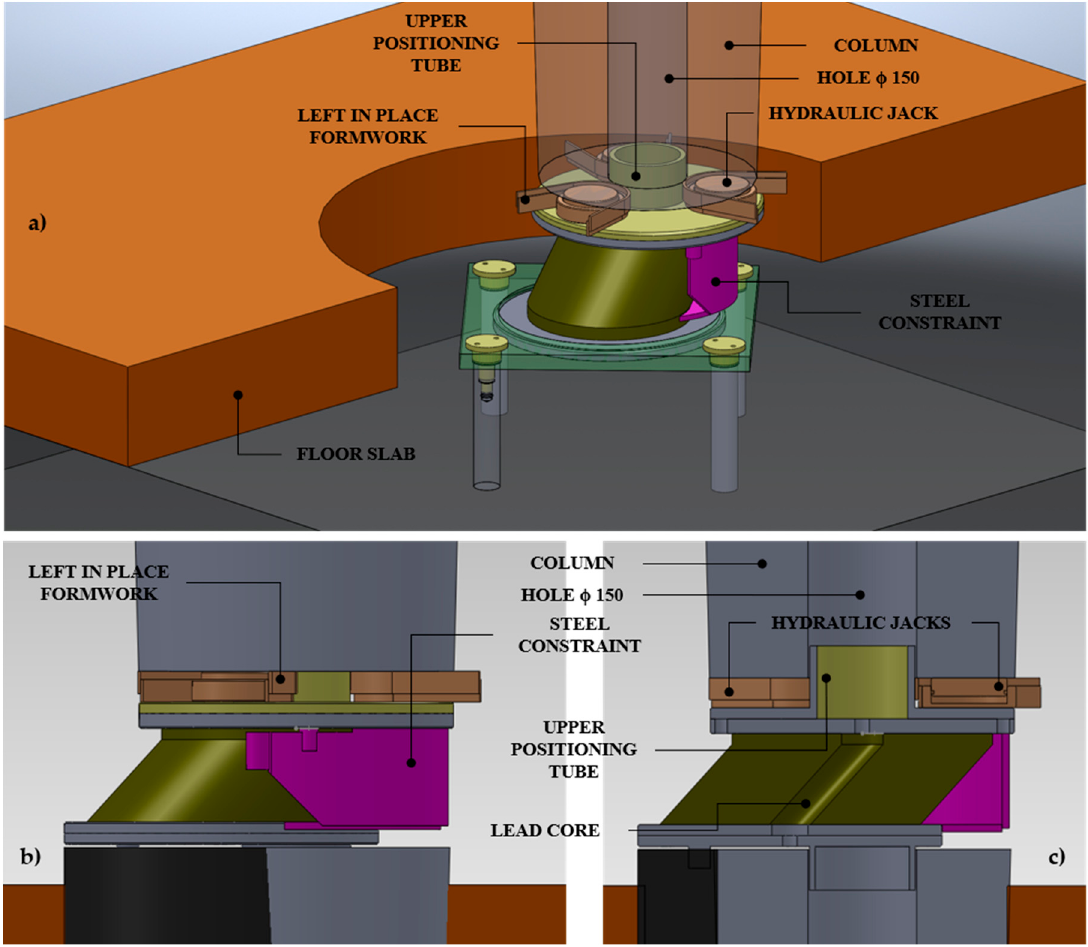
Figure 15. Some technical drawings (renderings) of the pre-deformed LRB isolator: ( a ) axonometric view; ( b ) lateral view; ( c ) vertical cross section along the diameter corresponding with the direction of translation. Table 3. Physical and mechanical properties of LRB (rubber only), lead, and stainless steel-Poly- TetraFluoroEthylene (PTFE) interface.